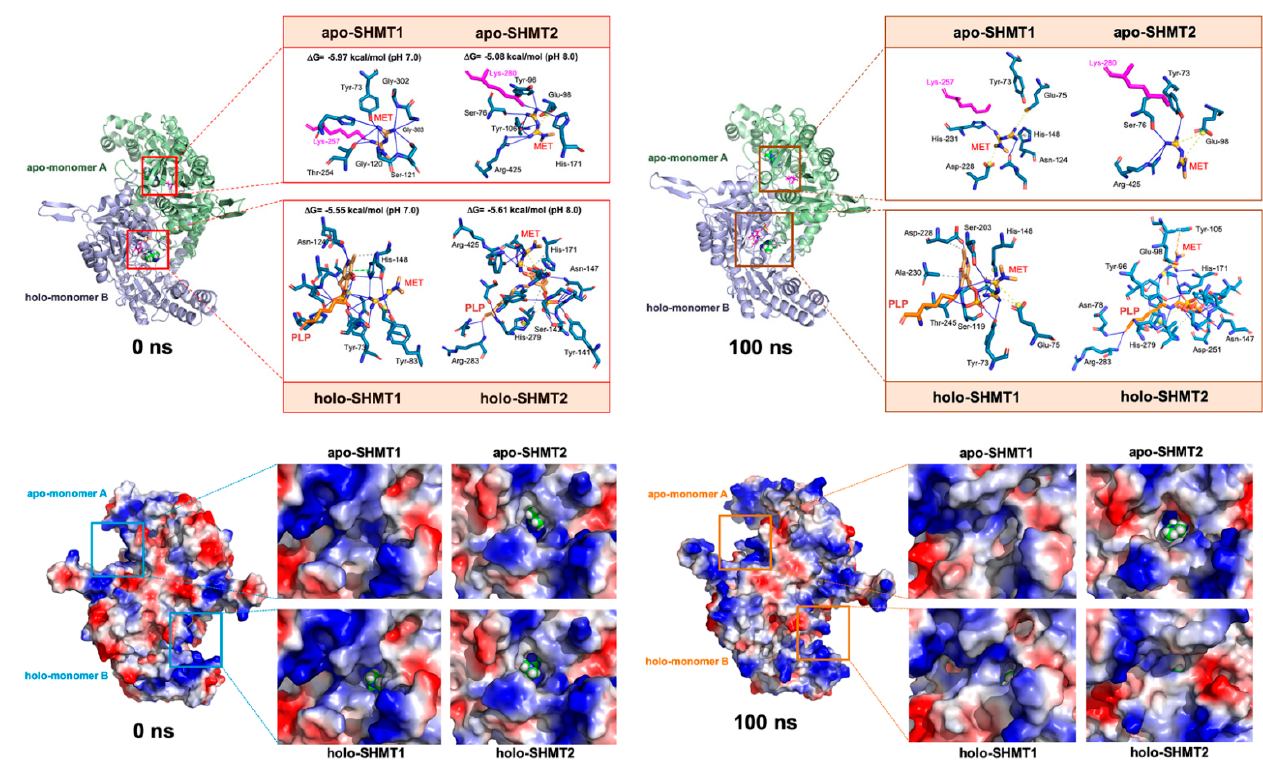
Figure 2. Metformin is computationally predicted to target the PLP-binding cavity of SHMT. Top panels. Models of incorporation of the predicted PLP binding cavity-targeting metformin behavior in human SHMT1 and SHMT2. Figures show the composition of a closed apo-SHMT (monomer A, pale green) and holo-SHMT (monomer B, light blue) before (0 ns) and after (100 ns) a molecular dynamics simulation in which a docked metformin (MET) molecule (represented as spheres) is included in the PLP binding cavity of both subunits. Insets show the detailed interactions of the best poses of MET docked to the PLP-binding site of SHMTs using the PLIP algorithm, indicating the participating amino acids in- volved in the interaction and the type of interaction (hydrogen bonds, hydrophilic interactions, salt bridges, Π -stacking, etc.). Insets in the left panel include also the Gibbs free energy variation ( Δ G, kcal/mol) values calculated from molecular docking experiments (pH 7.4) using YASARA v19.9.17 software. Bottom panels. Surface representation of closed SHMT dimers before (0 ns) and after (100 ns) a molecular dynamics simulation. Proteins are represented as a function of the hydrophobicity of its surface amino acids and the Na + and Cl − ions have been eliminated to facilitate visualization. Insets show a detailed view of the PLP binding cavity in SHMT1/2 enzymes. A MET molecule (sphere) is shown when visible from outside the cavity. Figures were prepared using PyMol 2.3 software.